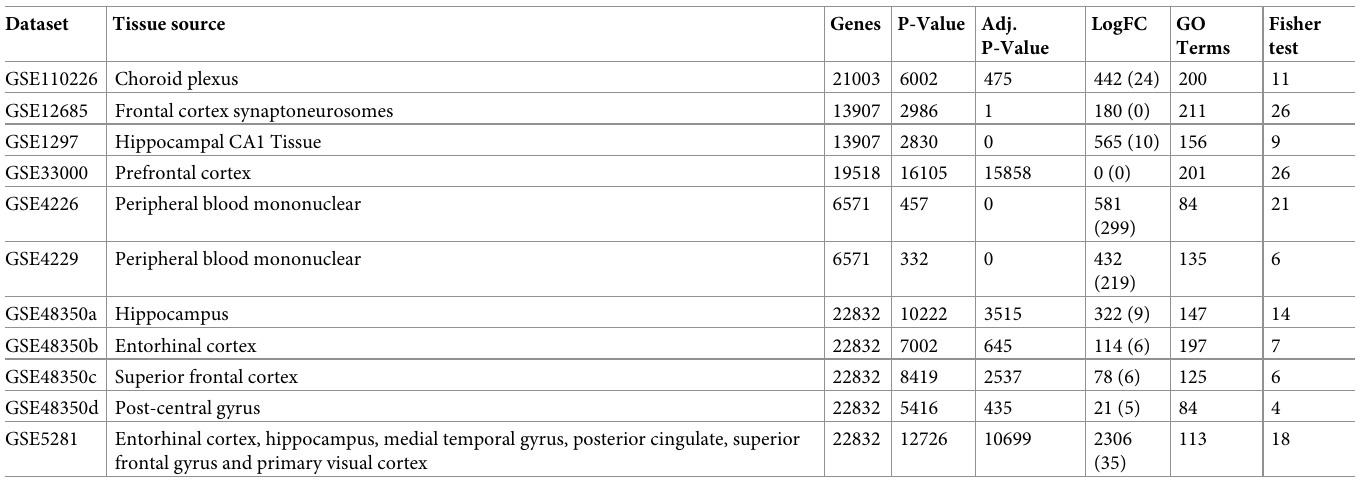
Table 1. Statistical summary for AD